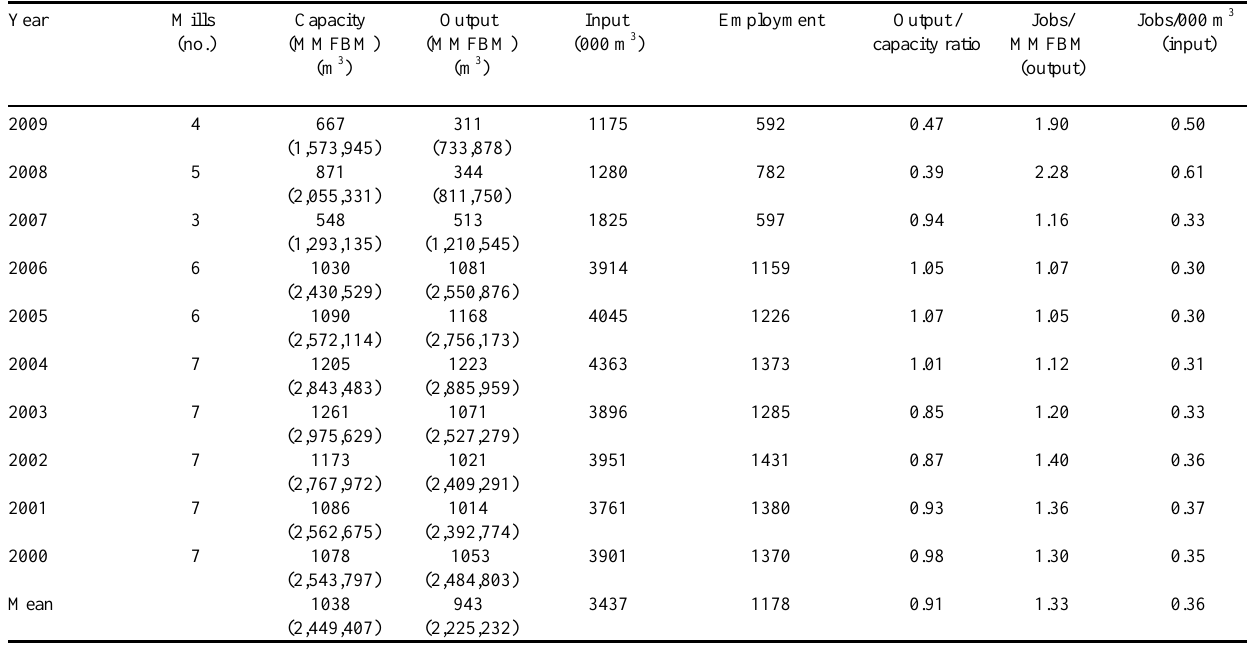
Table 4 . Output/capacity ratio and jobs per unit of input and output for commodity mills, 2000 to 2009 ( personal communication , Sinclair Tedder, senior economist, Competitiveness and Innovation Branch, British Columbia Ministry of Forests and